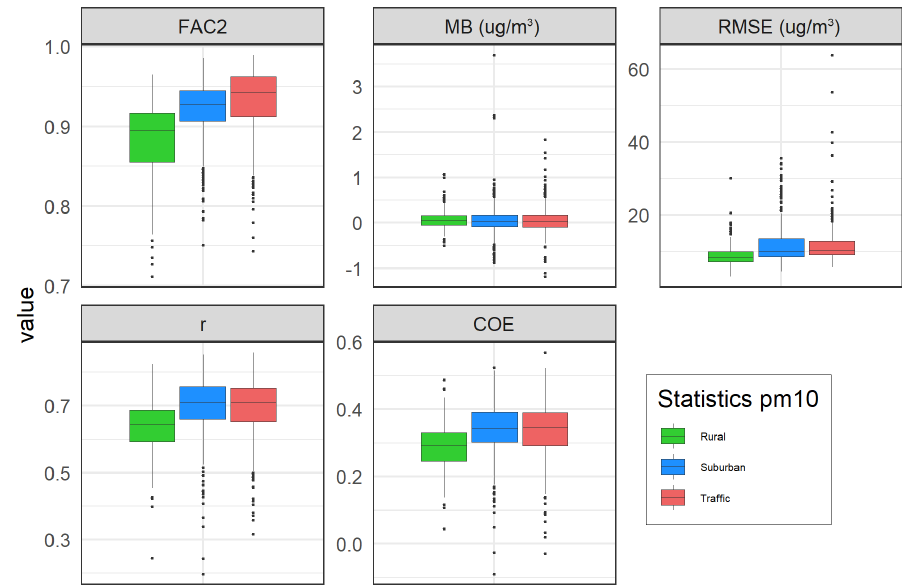
Figure 10. Box plots of evaluation parameters from the cross-validation for 2005–2019 (again for the same three types of stations).